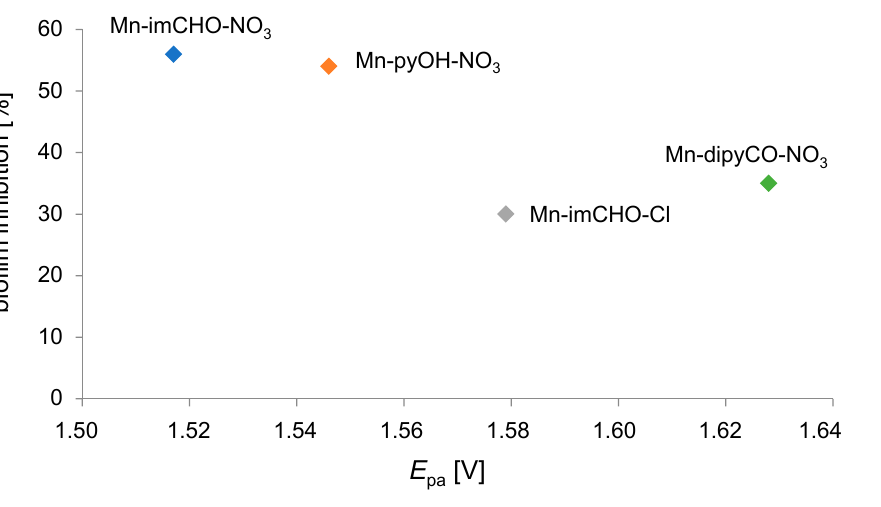
Figure 13. Correlation between the oxidation potential ( E pa ) for the Mn(II)/Mn(III) couple and the percentage biofilm inhibition against P. aeruginosa PAO1 strain.